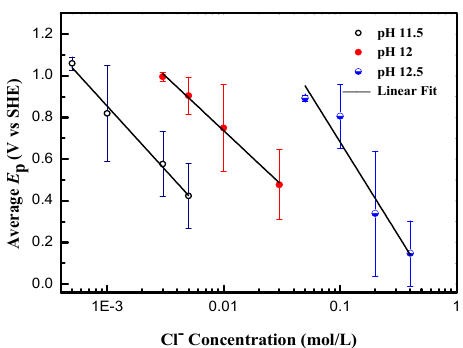
Figure 9. Variation of the average value of pitting corrosion potential with chloride ion concentration at various pH values.